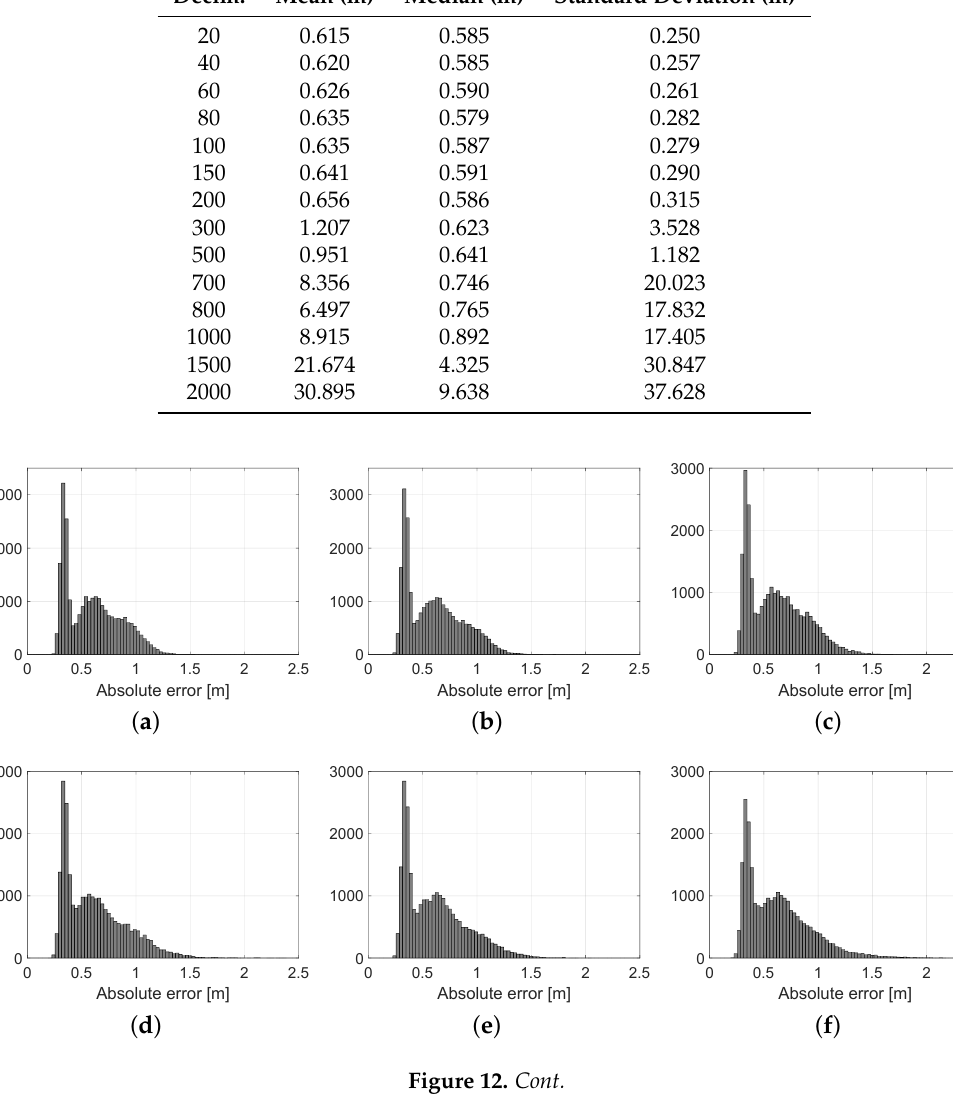
Figure 11. Positioning error and computational cost per timestep for different values of the likelihood function decimation parameter. Black: 95% confidence intervals (ellipses deformed due to the logarithmic scale) for 25 experiments, red: mean values. Note that the initial error and uncertainty are larger than during the steady state of the tracking algorithm, since particles are initially uniformly-distributed over an area of 30 × 30 m 2 . See Section 6.6 in the text for more details. Table 3. Localization error statistics for different decimation ratios applied to the input sensory data. Decim.